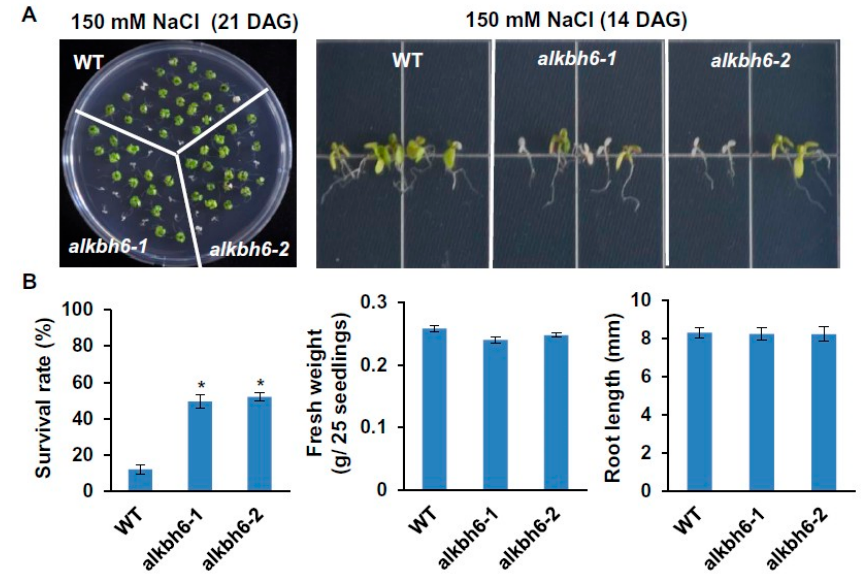
Figure 3. Seedling and root growth of the alkbh6 mutants under salt stress. ( A ) Wild-type Arabidopsis (WT) and alkbh6 mutants were grown on solid MS medium supplemented with 150 mM NaCl, and photographs for seedlings and roots were taken at the indicated days after germination (DAG). ( B ) Survival rate and fresh weight were measured 21 DAG, and root lengths were measured 14 DAG. Values are the mean ± SE obtained from three independent experiments, and the asterisks above columns indicate significant differences (* p ≤ 0.05).